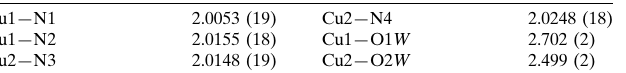
Selected bond lengths (A˚ ).